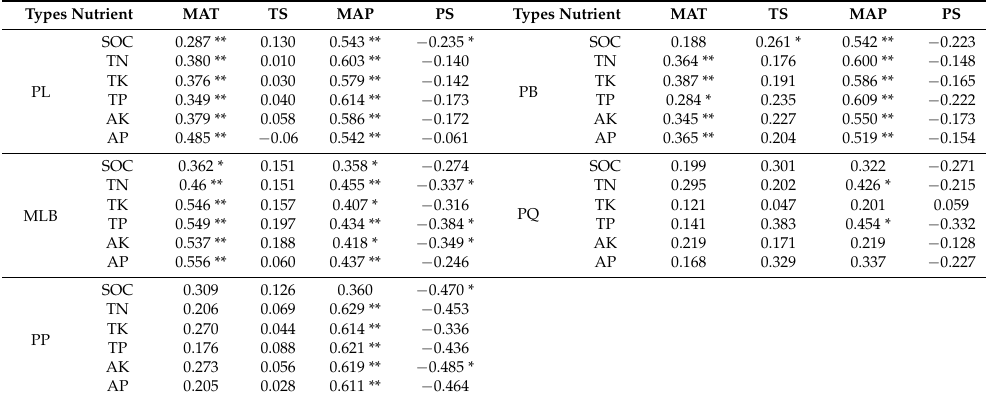
Table 3. Pearson correlations ( r ) between soil nutrients and climatic factors in the five main forest types. Types